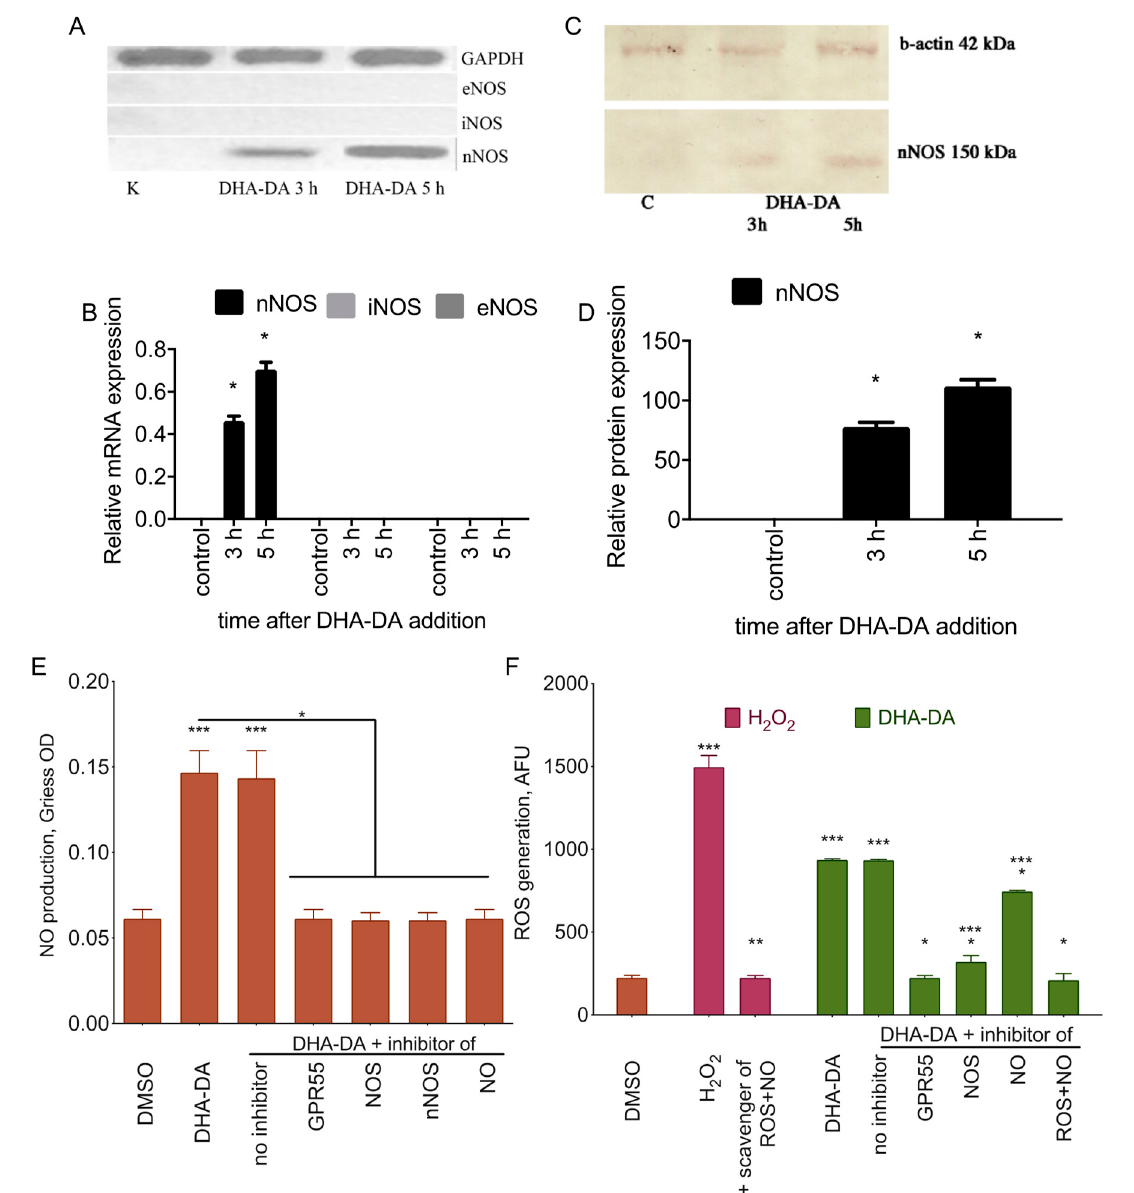
Figure 7. N-docosahexaenoyl dopamine (DHA-DA) induces neuronal NO synthase (nNOS) mRNA expression with a consequent ROS and NO production. ( A , B ) NO synthase mRNA expression (iNOS, inducible NO synthase, eNOS, endothelial NO synthase), ( C , D ) NO synthase protein expression, ( E ) NO and ( F ) ROS production after the undifferentiated PC12 treatment with DHA-DA (16 µ M) in comparison with hydrogen peroxide (500 µ M) ROS induction. Incubation time for E and F was 42 h. Blockers and inhibitors: GPR55, O-1918 (3 µ M), N OS, L-NMMA (3 µ M), nNOS, ARL 1477 (10 µ M), NO, PTIO (5 µ M), ROS + NO, Ac-Cys (5 µ M). NO was detected using the Griess assay, and ROS was detected using a fluorometric ROS detection kit. Data are presented as mean ± S.E., n = 3 experiments. *, a statistically significant difference from the DHA-DA without inhibitors; **, a statistically significant difference from H 2 O 2 without inhibitors; ***, a statistically significant difference from DMSO, ANOVA with the Tukey post-test, p ≤ 0.05. NOS isoforms mRNA expression was detected using RT-PCR, quantified using densitometry and normalized to the GAPDH housekeeping gene; data are presented as mean ± S.E., n = 3 experiments. nNOS protein expression was detected using Western blotting with antibody staining, quantified using densitometry and normalized to the b-actin; data are presented as mean ± S.E., n = 3 experiments. *, a statistically significant difference from untreated control, ANOVA with the Tukey post-test, p ≤ 0.05.